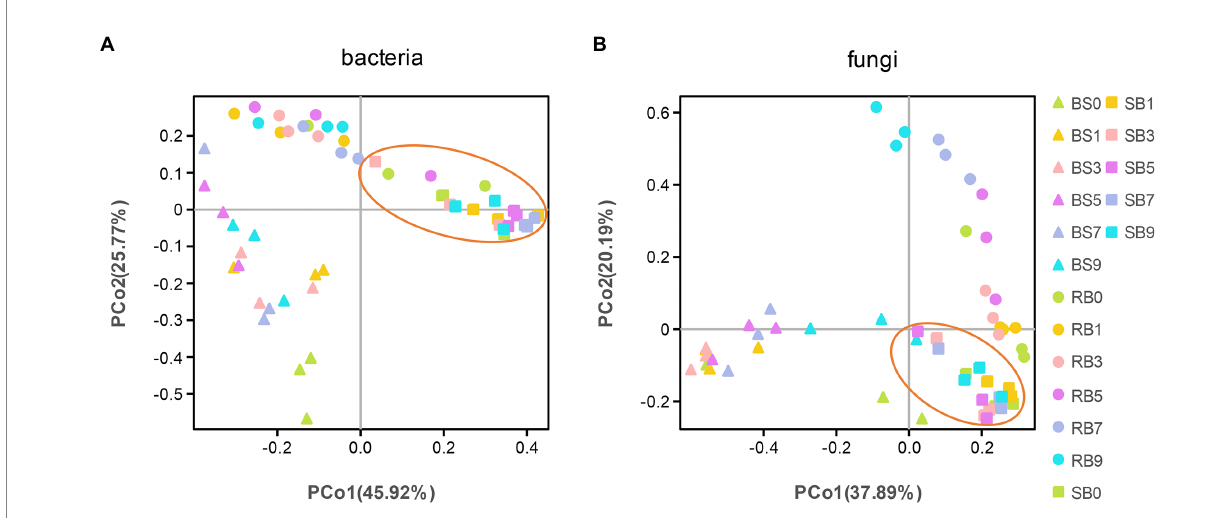
FIGURE 2 (A, B) Principal Coordinate Analysis (PCoA) of the bacterial and fungal community of the WPCS during different aerobic period. BS, Bunker silo; RB, Round bale; SB, silage bag. 0, 1, 3, 5, 7, 9: 0, 1, 3, 5, 7, 9 days of aerobic exposure,